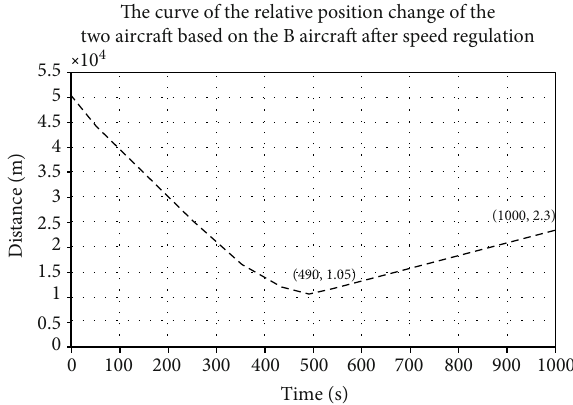
Figure 9: The relative position change of the two aircraft after the speed adjustment of the B